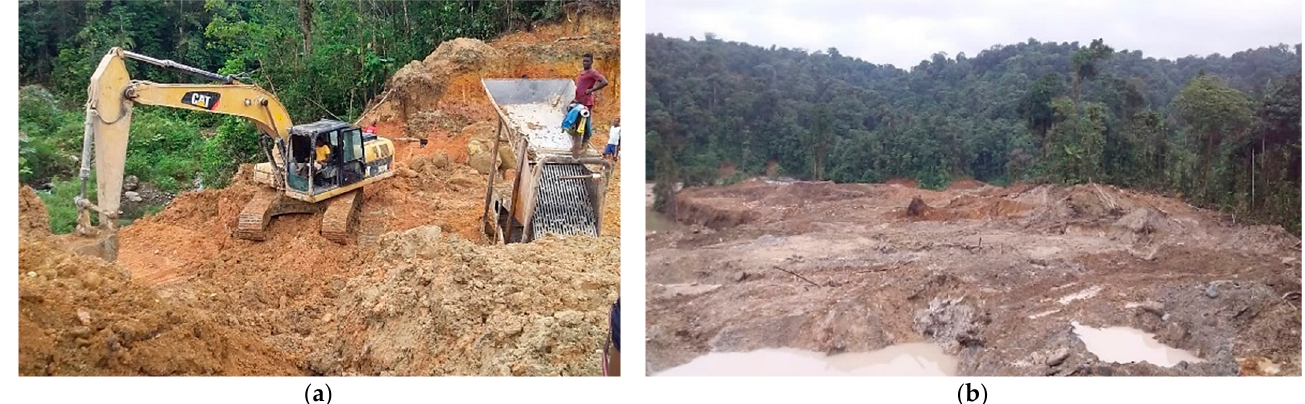
Figure 4. Invasion by illegal miners. ( a ) Machinery used for gold extraction; ( b ) deforestation of the affected area.